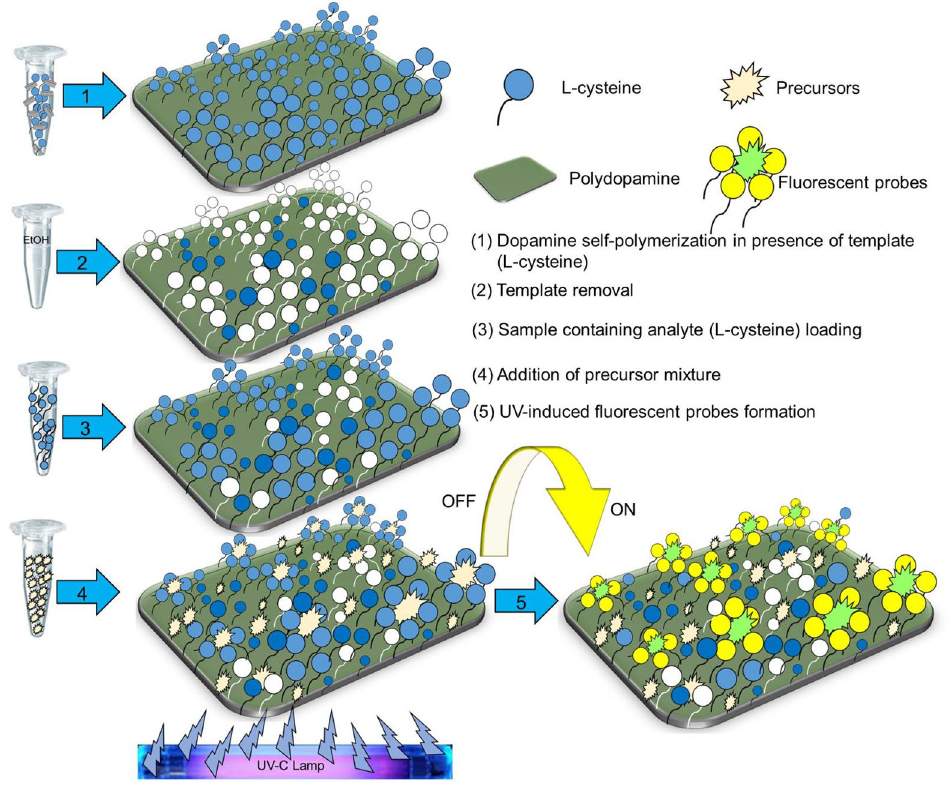
Figure 2. The principle and the process of the detection of